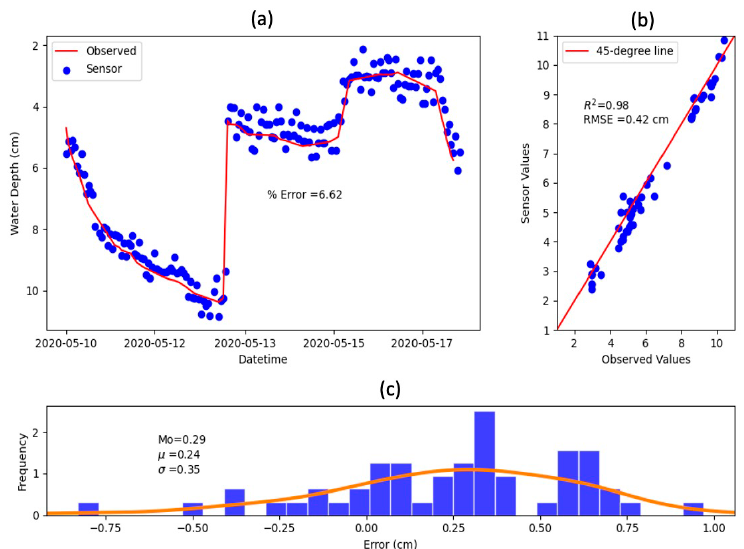
Figure 8. Laboratory-based performance test of Sensor 2 showing ( a ) observed and sensor’s water level measurements through time, ( b ) comparison of observed and sensor values, and ( c ) error (observed sensor) distribution with Gaussian KDF fit.